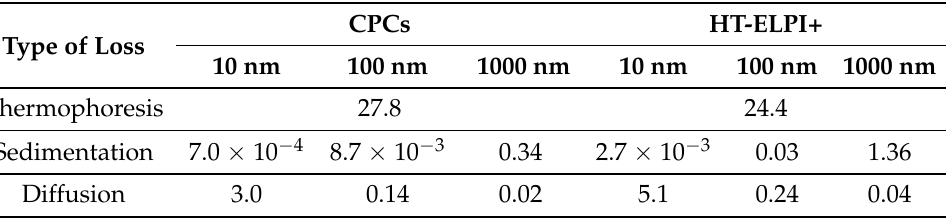
Figure A1. Schematic figure of the experimental setup used for particle emission measurement and the lengths of the pipes. Table A1. Particle losses in percentage for the CPCs and the HT-ELPI+ in the measurement setup used for different particle